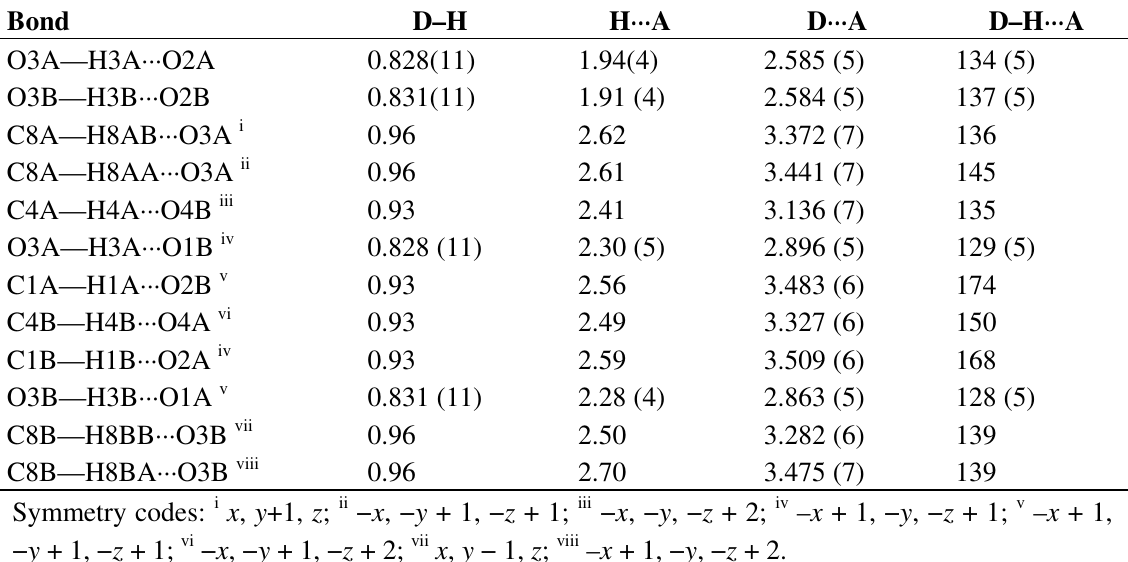
Table 1. Hydrogen-bond geometries for compound I.